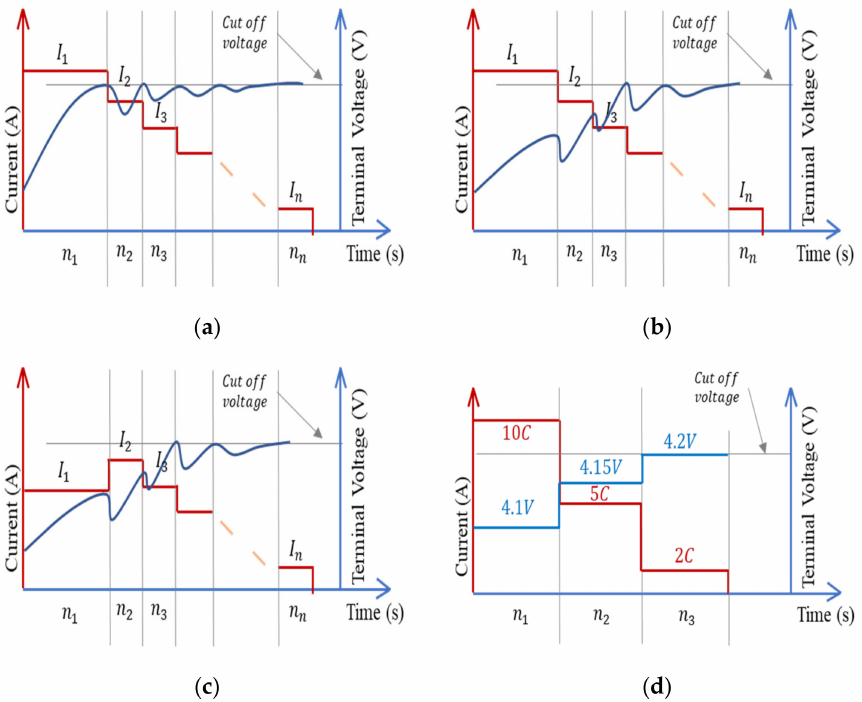
Figure 4. Schematic diagram of the Multi-Stage Charging Current (MSCC) Protocol where ( a ) The charging current stage changes whenever the battery voltage reaches the cut-off voltage, ( b ) the Hier- archical technique (HT), ( c ) the Conditional random technique (CRT), and ( d ) multilevel multistage constant current-constant voltage superfast charging (ML MCC-CV)